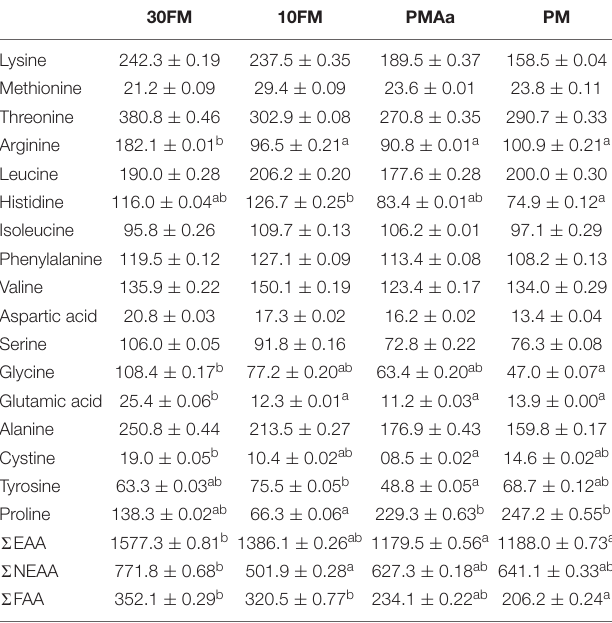
TABLE 10 | Dorsal muscle free amino acid concentrations ( µ g/g) in gibel carp fed dietary with different amino acid pattern about 45